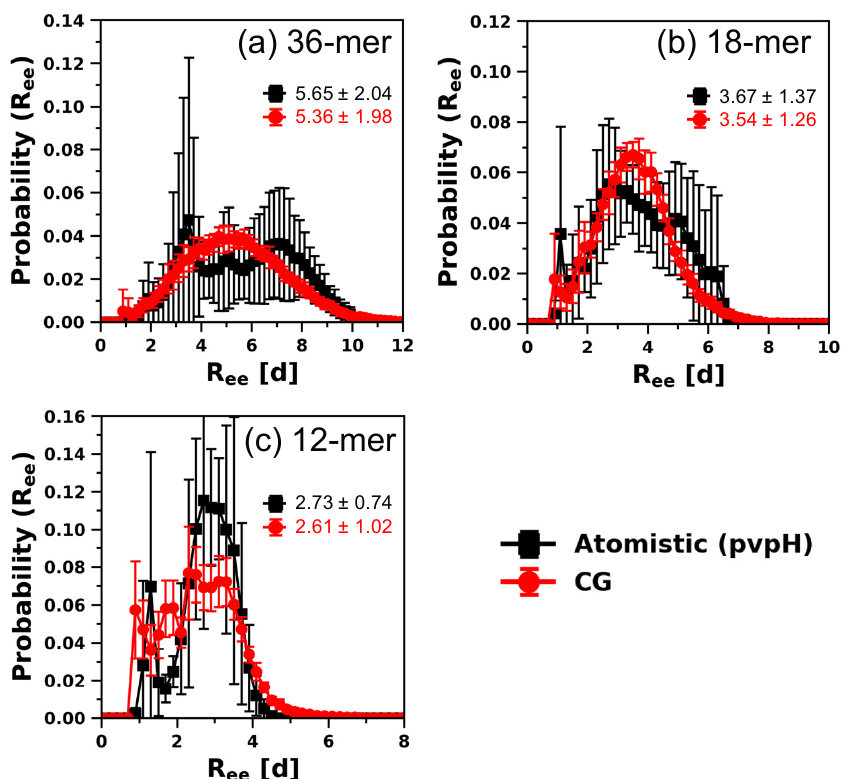
Figure 6. Comparison of distributions of R ee distance (with ensemble average values in reduced units (d)) for ( a ) 36-mer, ( b ) 18-mer, and ( c ) 12-mer pvpH chains, obtained from atomistic simulations and CG simulations (for the best performing case of attractive interaction between any two hydrogen bonding beads (H–H), ε HH , in the CG model equal to 7 kT and H–B–B (cid:48) -H (cid:48) torsional constraint simultaneously imposed). The standard deviations are computed from the means of 5 independent trials for atomistic simulations and 10 independent trials for CG simulations and the lines joining the symbols are drawn to guide the